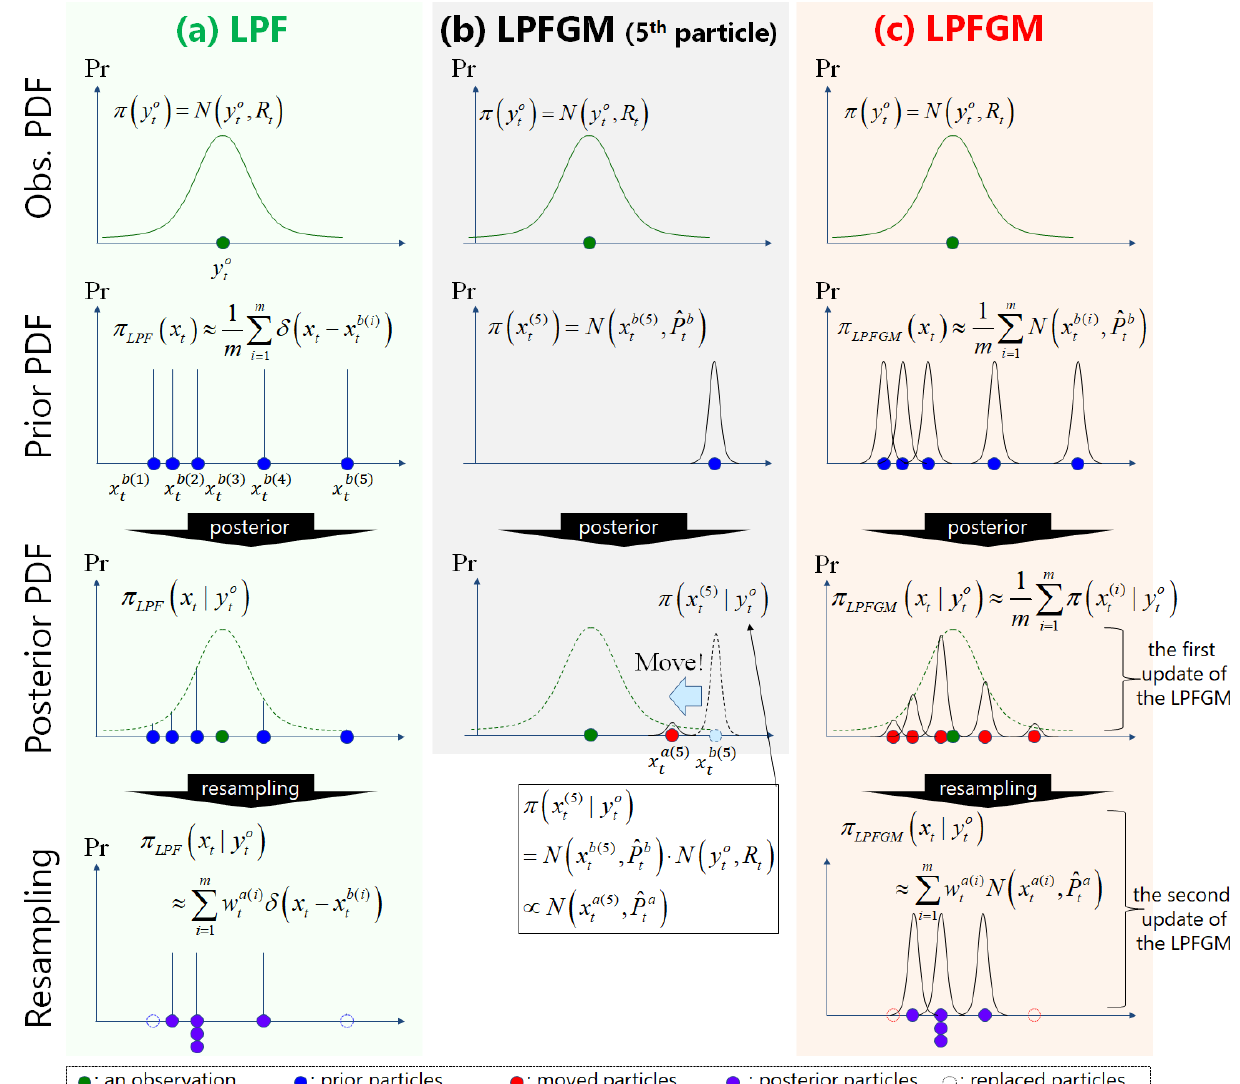
Figure 2. A simple scalar example of observation as well as prior and posterior PDFs for (a) LPF, (b) fifth particle of LPFGM, and (c) LPFGM. Green, blue, red, purple, and dashed circles represent an observation and prior particles, moved particles, posterior particles, and replaced particles,